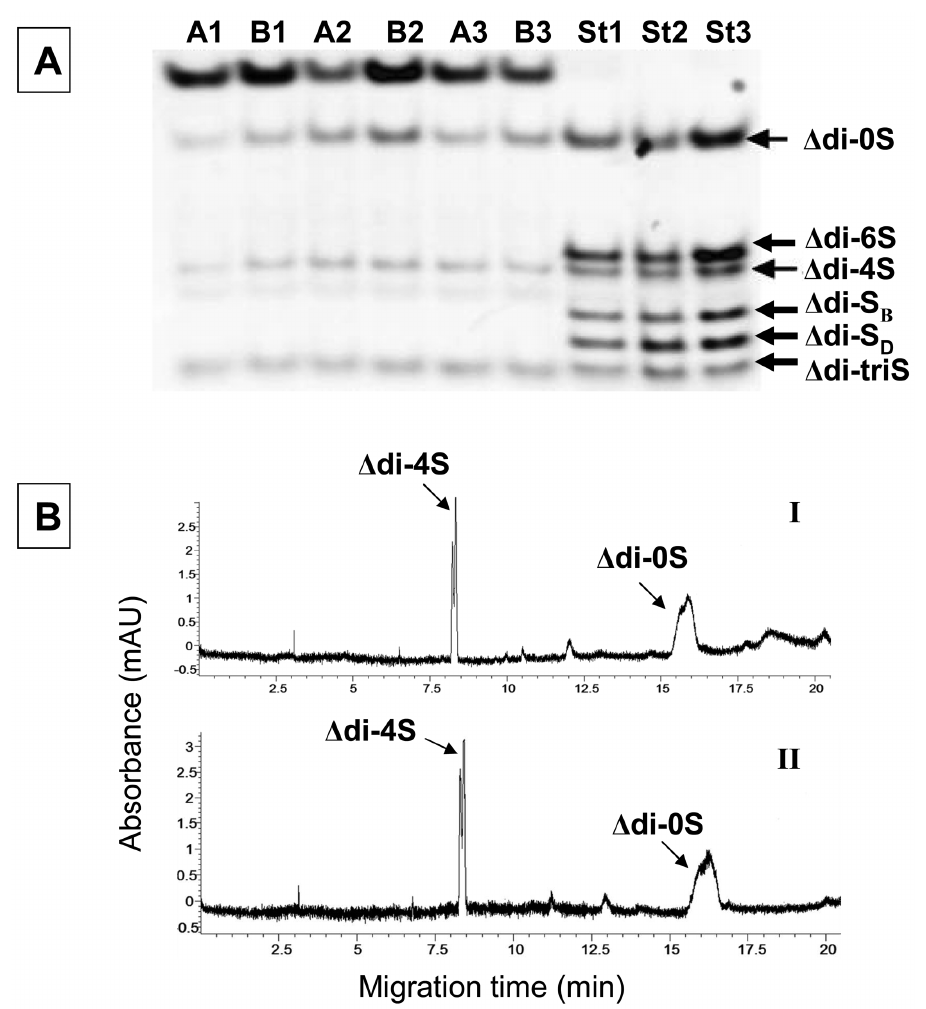
Figure 3. Panel ( A ): FACE analysis in blood serum samples from patients before and after coronary artery bypass surgery; the numbers 1–3 correspond to different patients and A, B in serum samples before and after surgery, respectively. The std1, std2, std3 are mixtures with standard disaccharides CS ( Δ di-4S, Δ di-6S and Δ di-0S) at a concentration of 6.0 μ g/mL, 8.0 μ g/mL and 10.0 μ g/mL, respectively. Panel ( B ): electropherograms